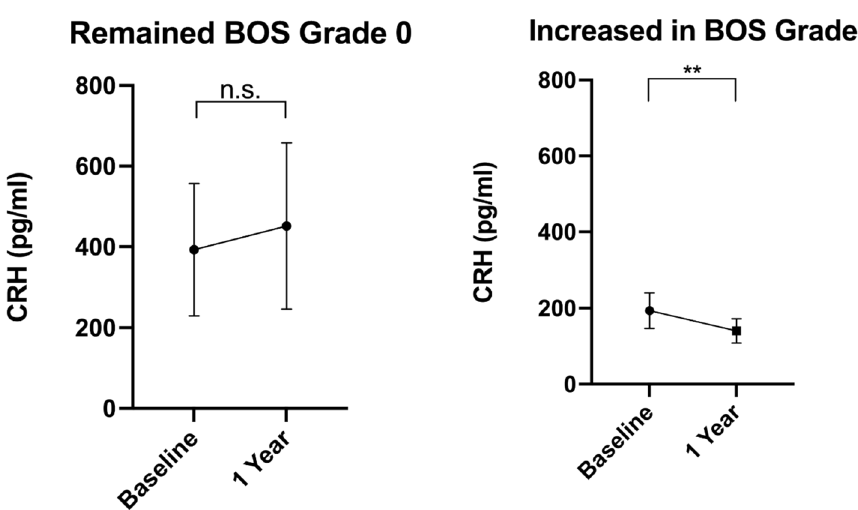
Figure 6. CRH Levels Tracked Through Patient Grade Changes. In comparing BOS grade 0 patients who maintained their status at the 1 year followup, later CRH levels are noted to not be statistically different from their baseline plasma concentrations ( A ). In patients who increased BOS grades after 1 year ( B ), CRH plasma levels were statistically lower in their second sample. ** p < 0.01. CRH, corticotropin releasing hormone; BOS, bronchiolitis obliterans syndrome.